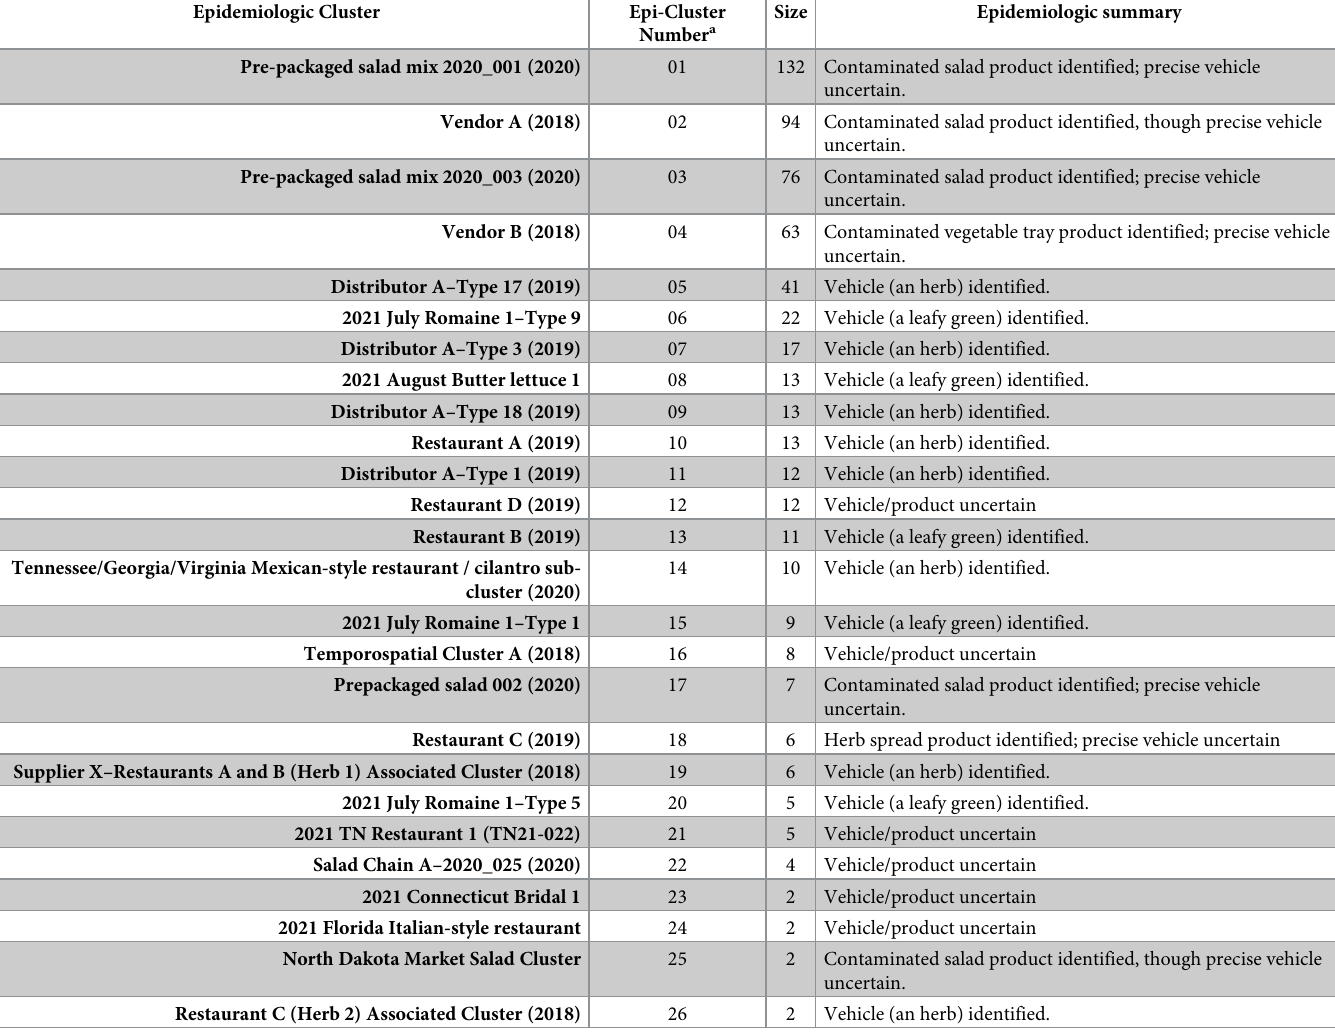
Table 1. List of epidemiologic clusters and their